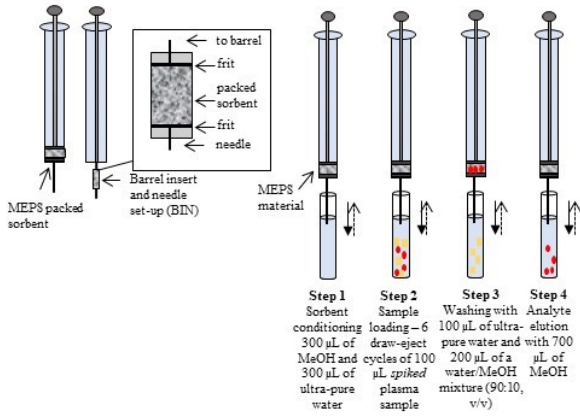
Figure 4. The schematic diagram for the MEPS procedure.